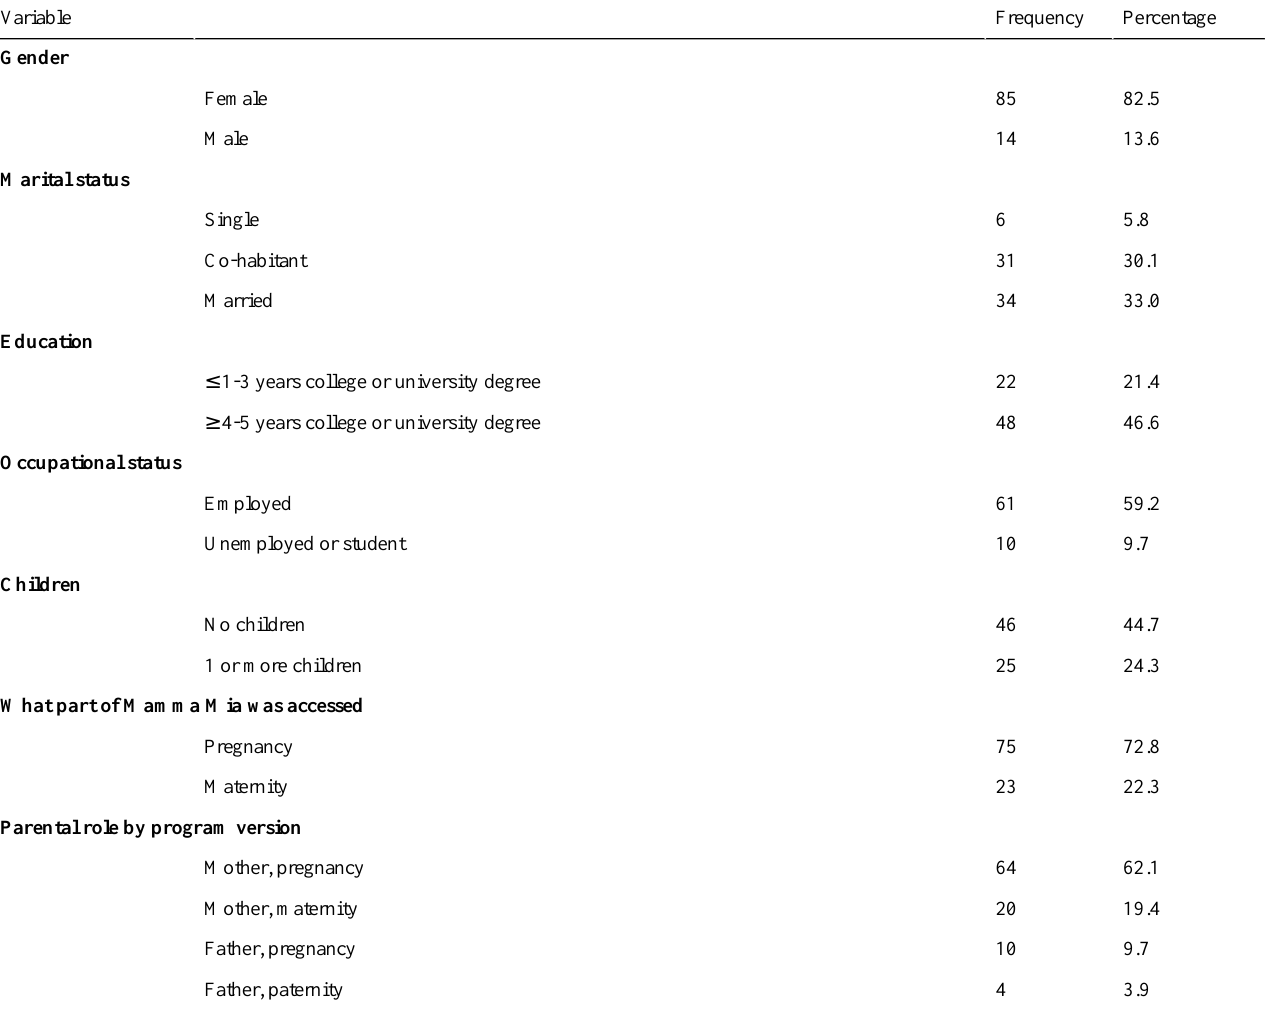
Table 2. Participant characteristics